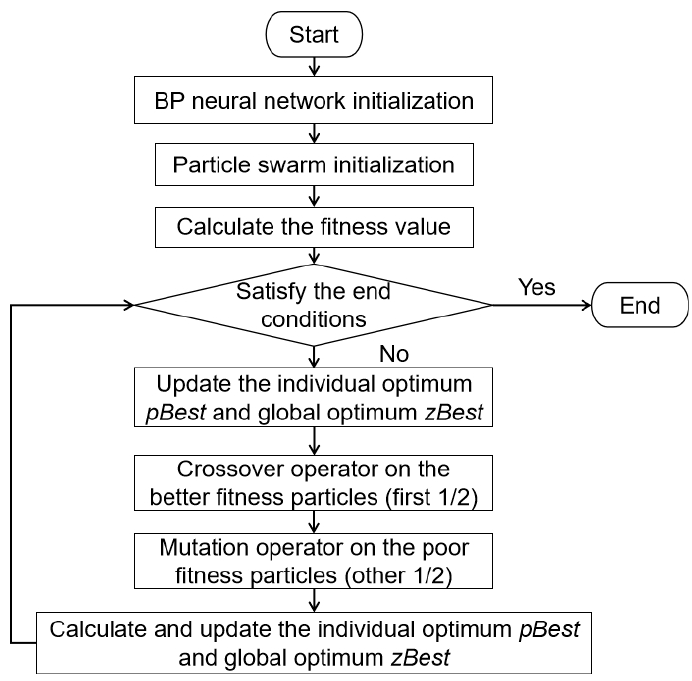
Figure 2. Flow chart of PSO-GA-BP neural network prediction model. 243